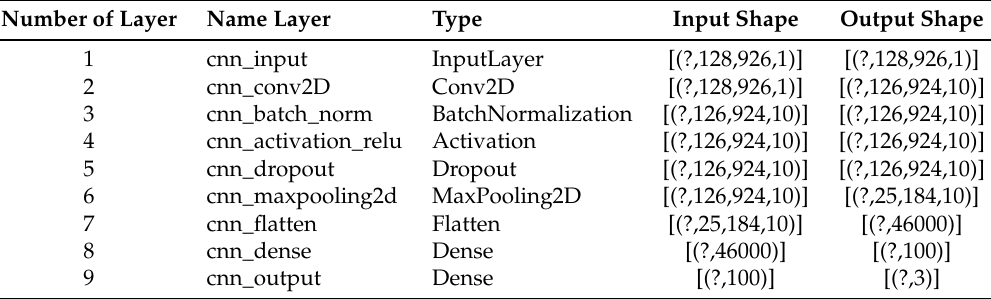
Table 4. Scheme of the classification neural network based on convolutional layers.